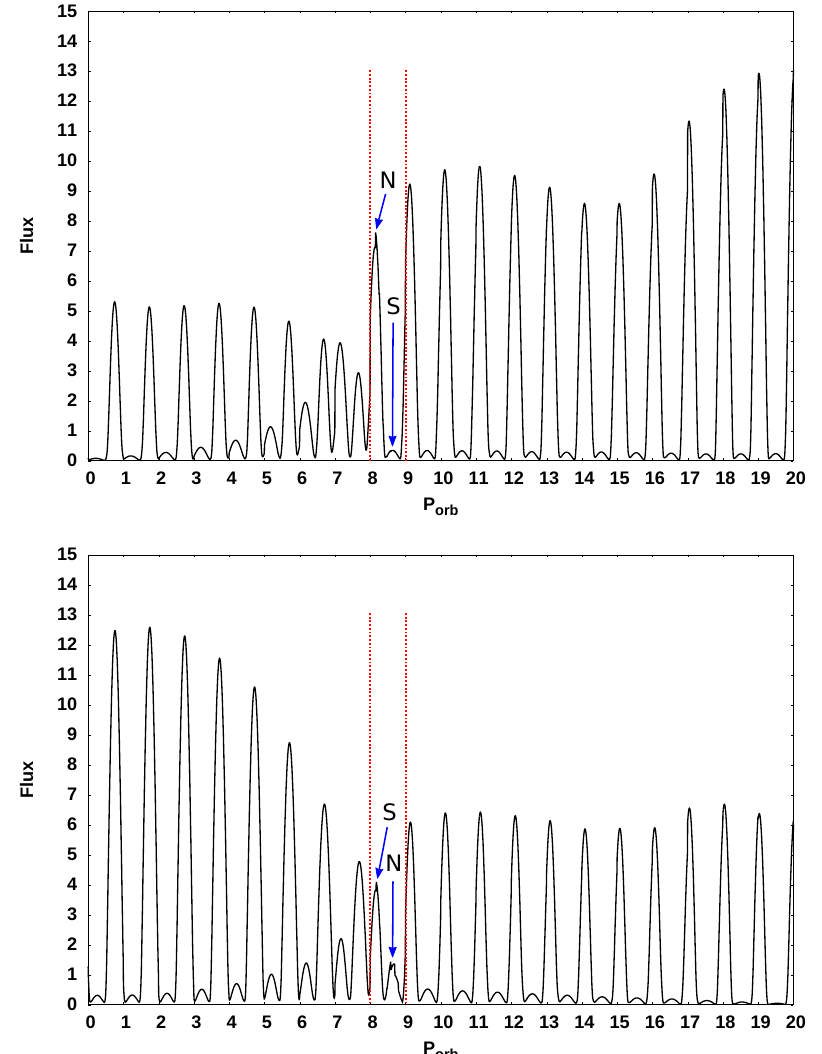
Figure 15. Bolometric light curves of the CD Ind polar for the magnitude of the dipole displacement − 0.5. The upper panel corresponds to switching from the south pole to the north, the lower panel does from the north pole to the south. The value of the flux is indicated in units 10 33 erg/s. The red dotted lines highlight the orbital period corresponding directly to the moment of switching. On the light curves, arrows mark the positions of the northern (N) and southern (S) hot